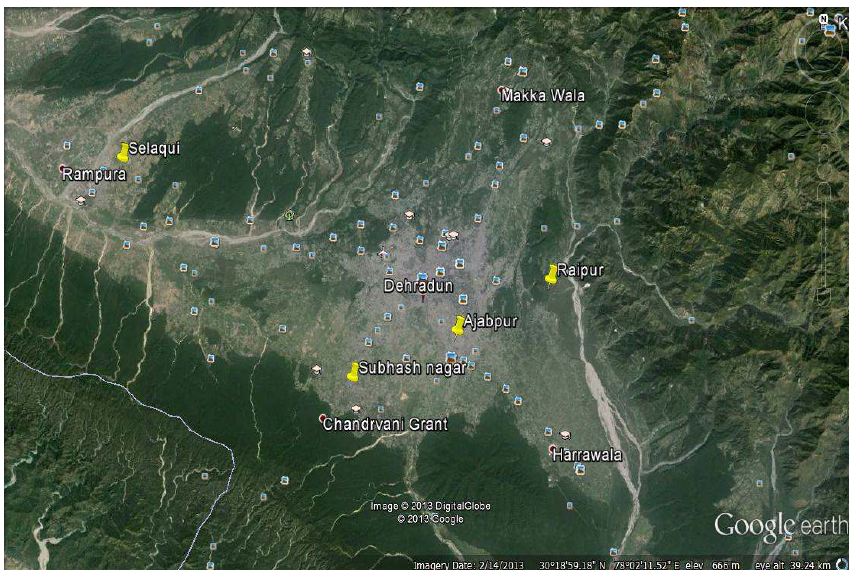
Figure-1. Map of study area: different areas of Dehradun (Raipur, Subhashnagar, Ajabpur and Selaqui region),